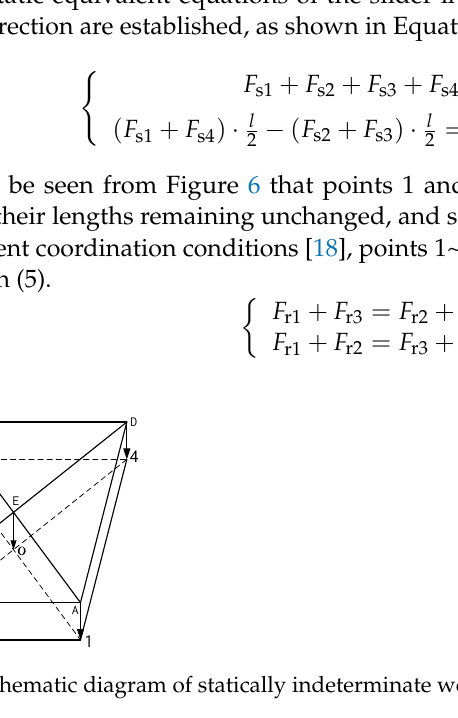
6 of 24 Figure 5. Load diagram of linear guide unit. {𝐹 r1 + 𝐹 r2 + 𝐹 r3 + 𝐹 r4 = 𝐹 Z + 𝑊 (𝐹 r1 + 𝐹 r2 ) ⋅ 𝐿 2 − (𝐹 r3 + 𝐹 r4 ) ⋅ 𝐿 2 = 𝐹 Y ⋅ 𝑍 Y + 𝐹 Z ⋅ 𝑌 Z + 𝑊 ⋅ 𝑌 W (𝐹 r1 + 𝐹 r4 ) ⋅ 𝑙 2 − (𝐹 r2 + 𝐹 r3 ) ⋅ 𝑙 2 = 𝐹 X ⋅ 𝑍 X + 𝐹 Z ⋅ 𝑋 Z + 𝑊 ⋅ 𝑋 W (10) 𝐹 r1 + 𝐹 r3 = 𝐹 r2 + 𝐹 r4